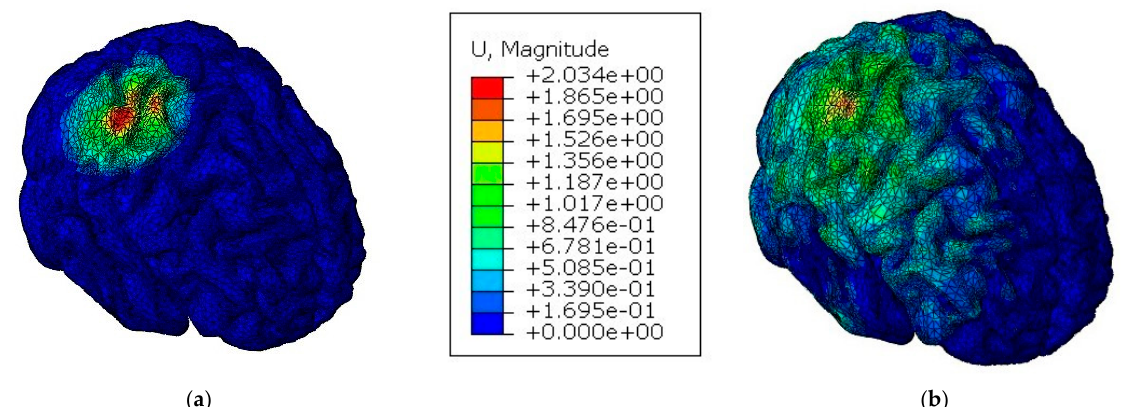
Figure 9. Displacement of the brain for both models [mm]: ( a ) model with the implant; ( b ) model with an integral skull. Table 4. Percentage of brain tissue within the thresholds that match the criteria defined.